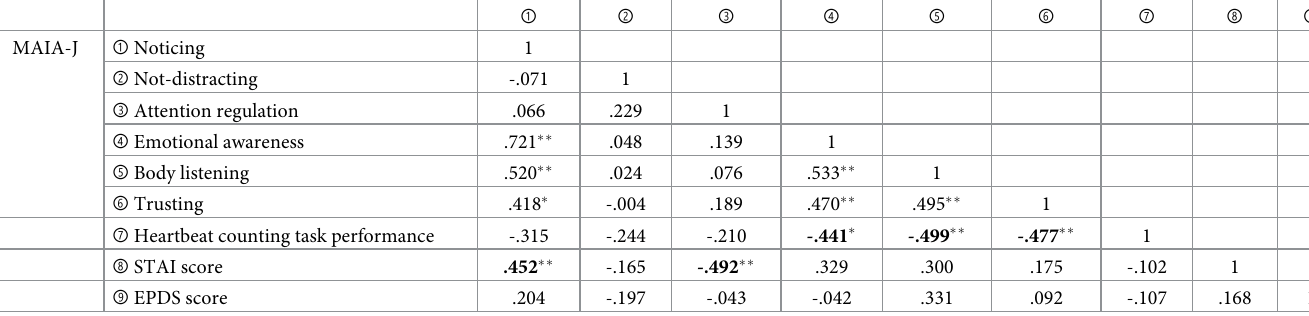
Table 4. Spearman correlations between interoception (sensibility and accuracy), anxiety, and